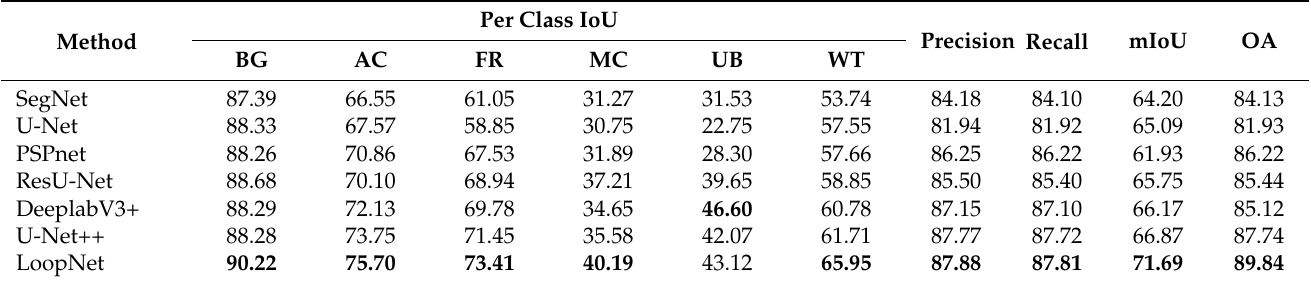
Table 3. Accuracy results (%) of network architectures on the land use